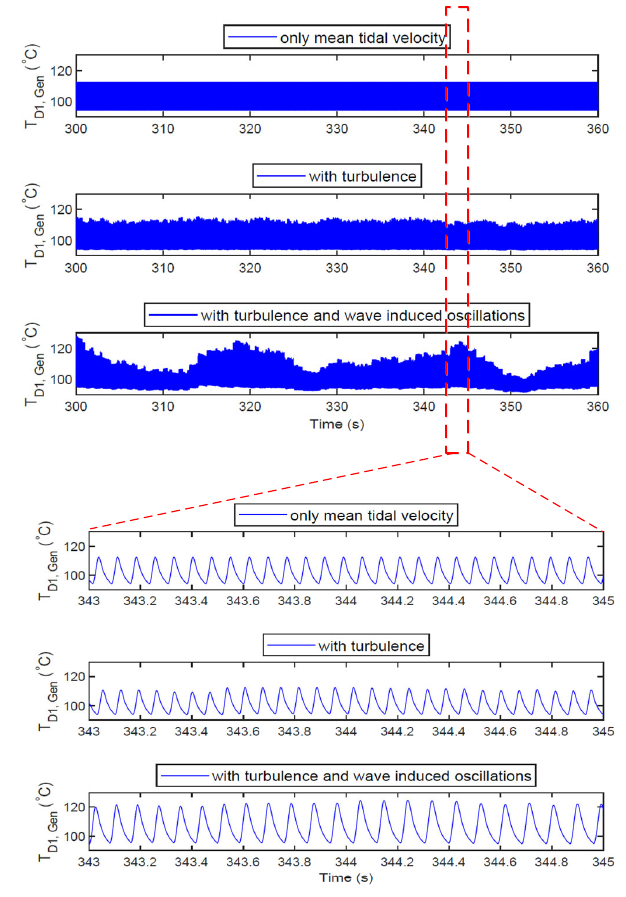
Figure 18. Temperature of the Generator Side Converter Diode (D1) as a function of the fluctuations in the tidal stream velocity.